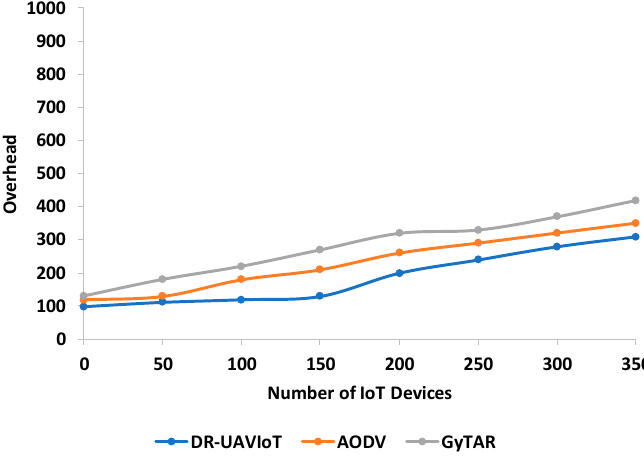
Figure 10. Overhead Analysis in the Presence of Different Numbers of IoT Devices.